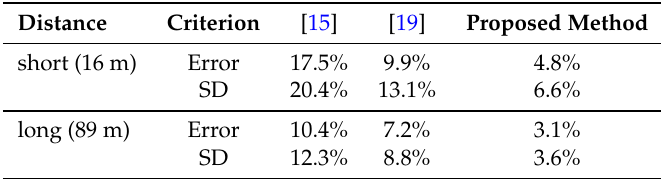
Table 4. Comparison with other